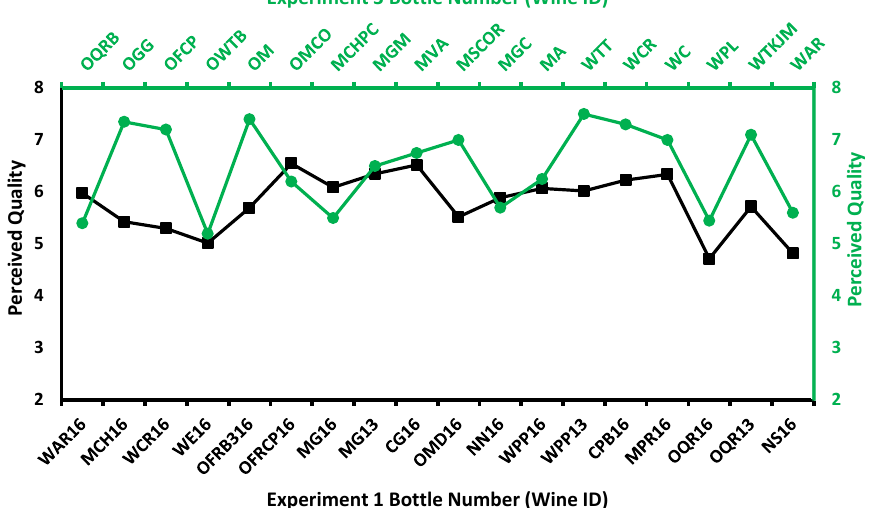
Figure 5. Perceived wine quality ratings for two different sets of New Zealand Pinot noir wine observed in Experiment 1 and Experiment 3.